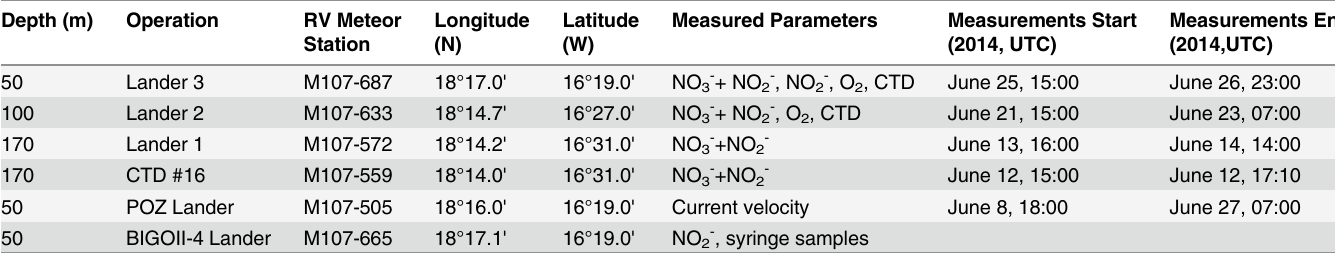
Table 1. Details of underwater operations during R/VMeteor cruise M107 where autonomous measurements were performed. Depth (m)